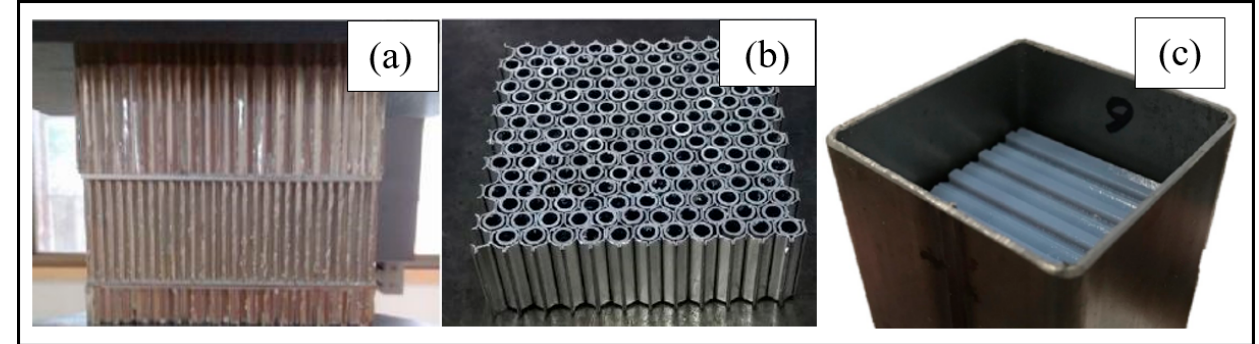
Figure 8. Innovation of honeycomb structures. ( a ) Tandem honeycomb structure, ( b ) honeycomb structure, and ( c ) honeycomb filled structure.